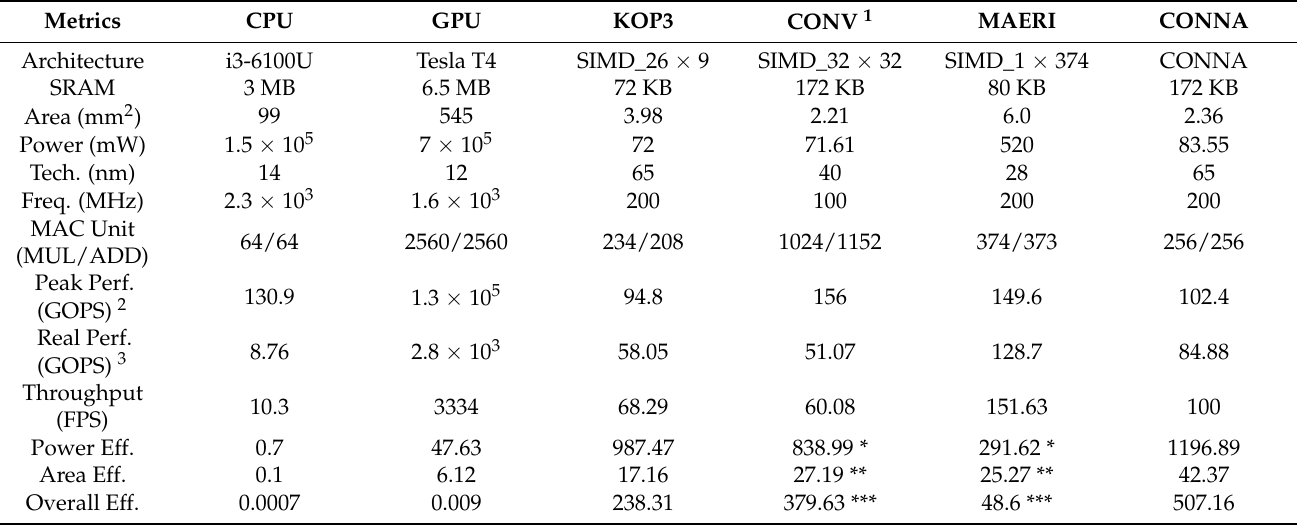
Table 10. Efficiency comparison with processors and the SIMD-based accelerators [21,22,24,43].